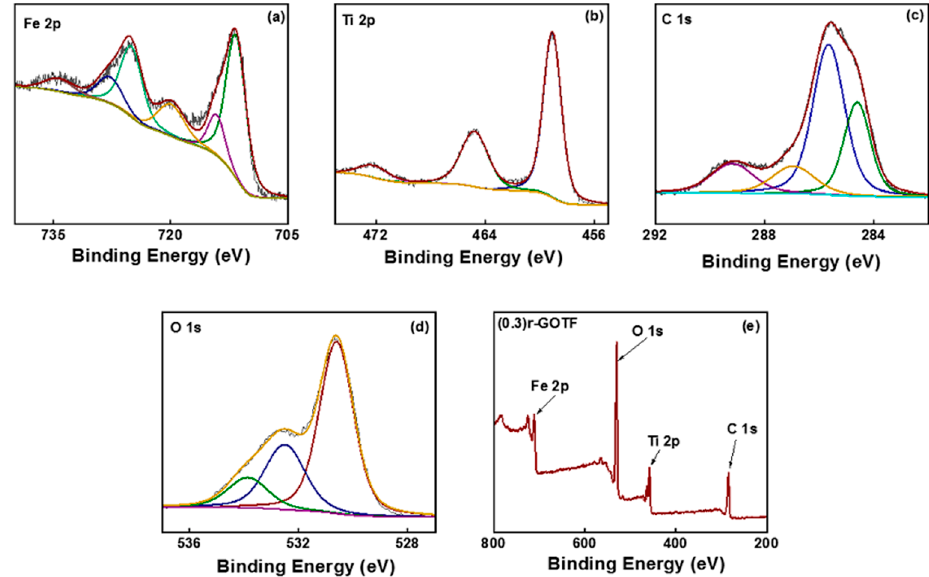
Figure 3. High-resolution XPS spectra of ( a ) Fe 2p of (0.3)r-GOTF, ( b ) Ti 2p of (0.3)r-GOTF, ( c ) C 1s of (0.3)r-GOTF, ( d ) O 1s of (0.3)r-GOTF, Survey spectra of ( e ) (0.3)r-GOTF.